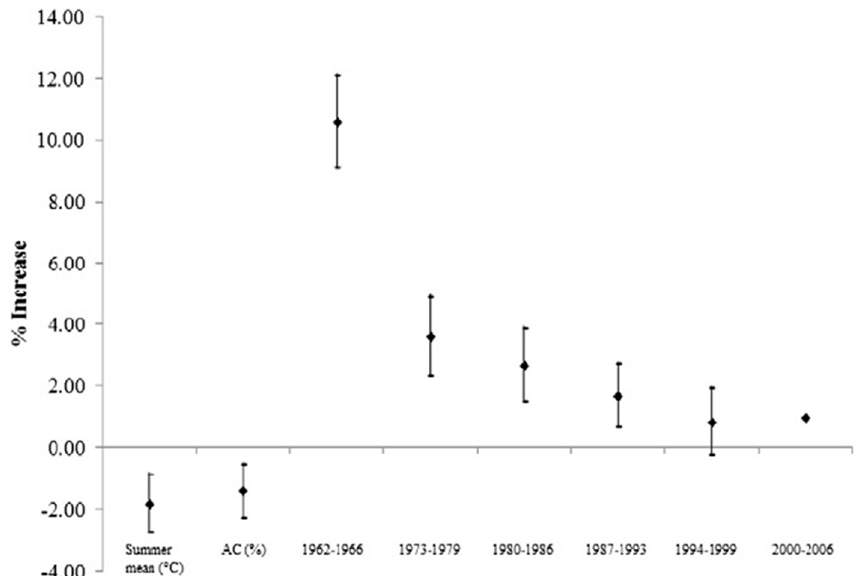
Figure 4. Heat-related mortality effect at 80 ◦ vs. 60 ◦ F, as a function of summer mean temperature, Figure 4. Heat ‐ related mortality effect at 80° vs. 60° F, as a function of summer mean temperature, AC% and time period. From Nordio et al., 2015 AC% and time period. From Nordio et al., 2015 [29].